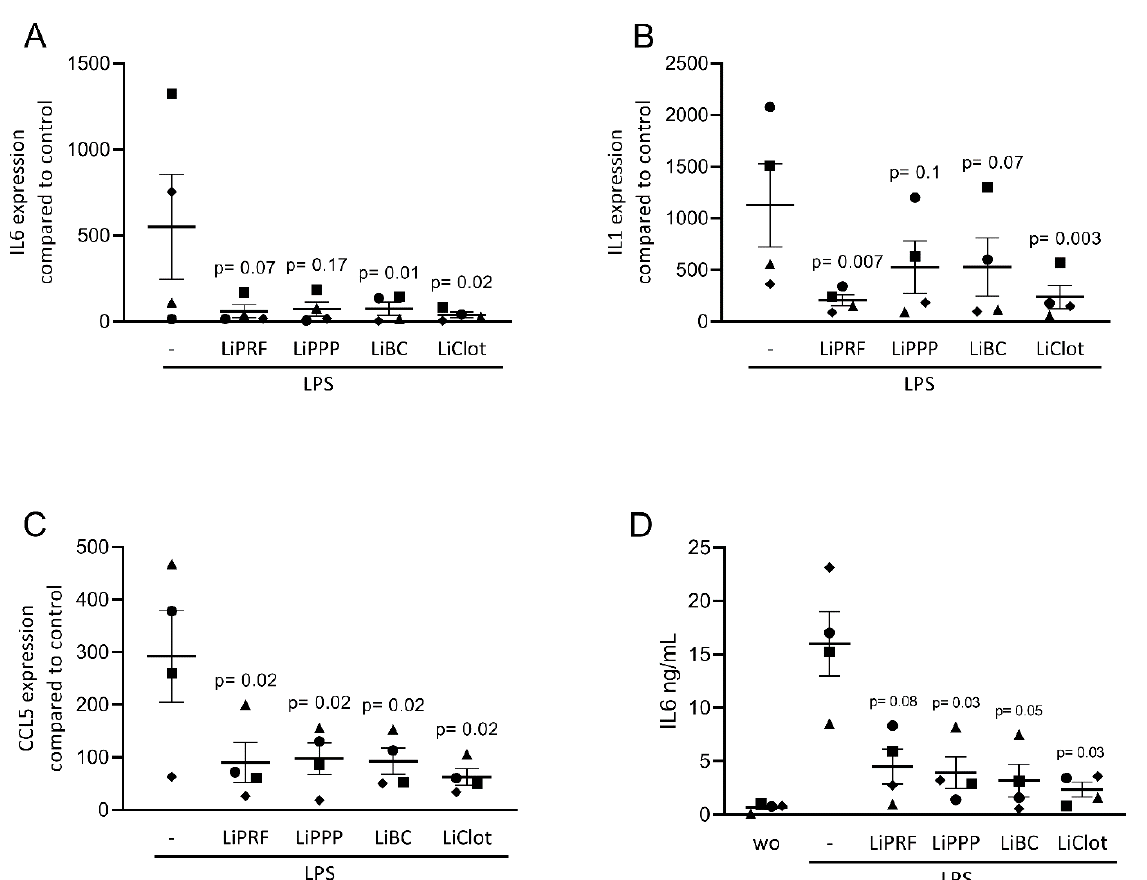
Figure 2. Lipids from PRF reduces the expression of inflammatory-related genes in LPS-treated primary macrophages. ( A – C ) Reduction in IL6, IL1, and CCL5 in LPS-treated primary macrophages was reported with lipid extracts from solid PRF (LiPRF), liquid PRF (LiPPP and LiBC) and blood clot (LiClot), mostly reaching the level of significance. ( D ) Data show the IL6 protein levels in the cell supernatant. Each data point represents an independent experiment. N = 4. For comparison of groups, the Friedman test was applied. WO means without and represents unstimulated cells.